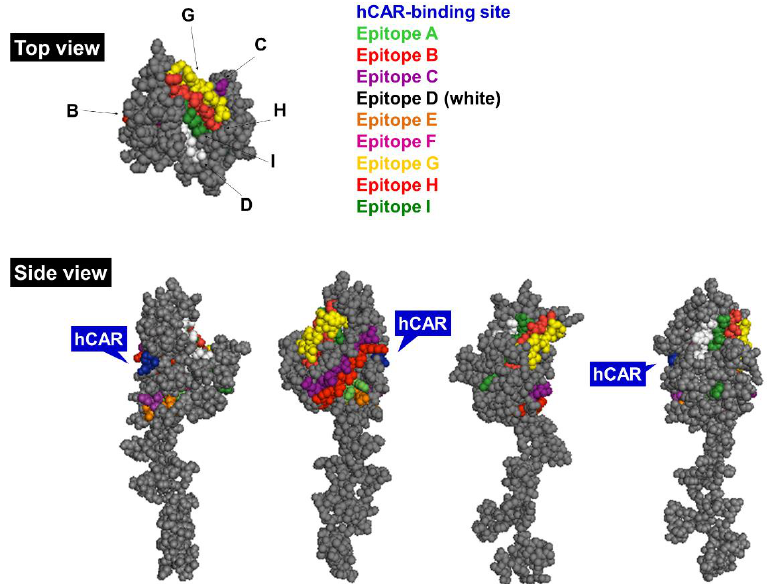
Figure 3. Side and top view of the Ad5 fiber monomer. Main antigenic epitopes are highlighted in distinct colors (see legend) and hCAR-binding site is indicated in blue [43]. The model was generated in PyMol version 1.1eval (PDB ID: 1KNB). hCAR, human coxsackie and adenovirus receptor.